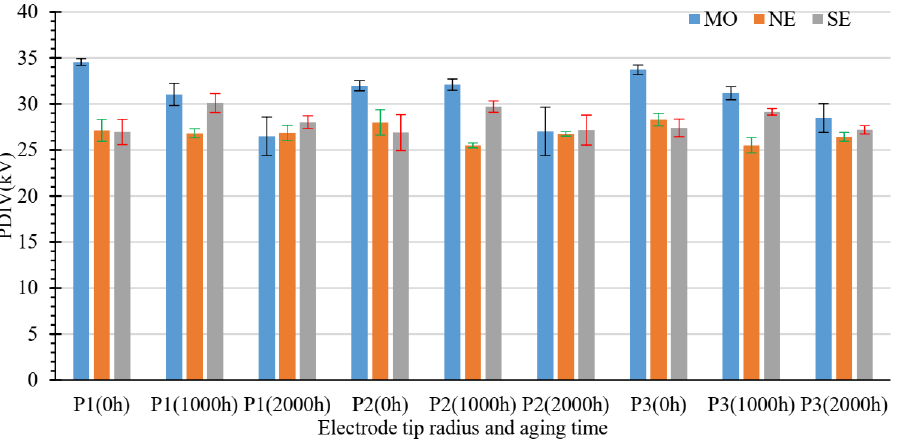
Figure 5. Partial discharge inception voltage as a function of the electrode radius and aging time.